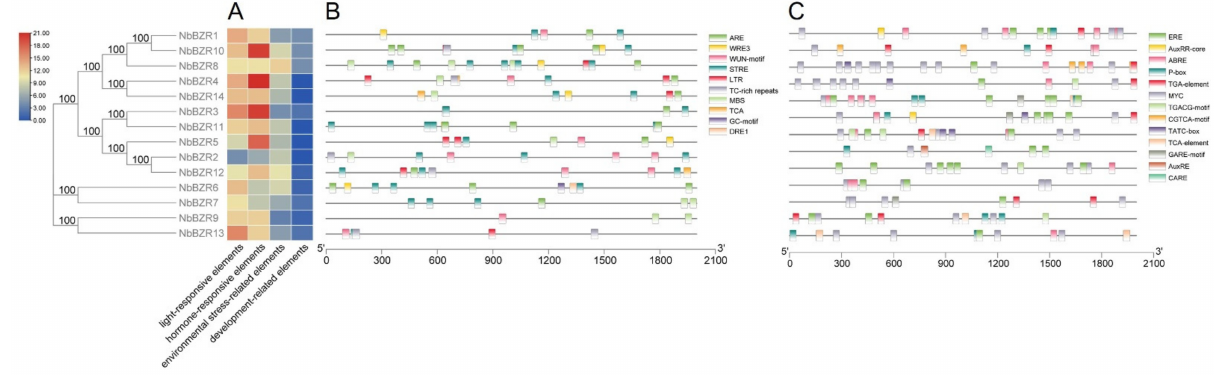
Figure 3. Prediction of cis-acting elements in the NbBZR promoter regions. ( A ) Schematic representation of the numbers of four types of cis-acting elements predicted in the promoter region of each NbBZR member. ( B , C ) The type, quantity and position of environmental stress-related elements ( B ) and hormone-response elements ( C ) in the NbBZR promoter